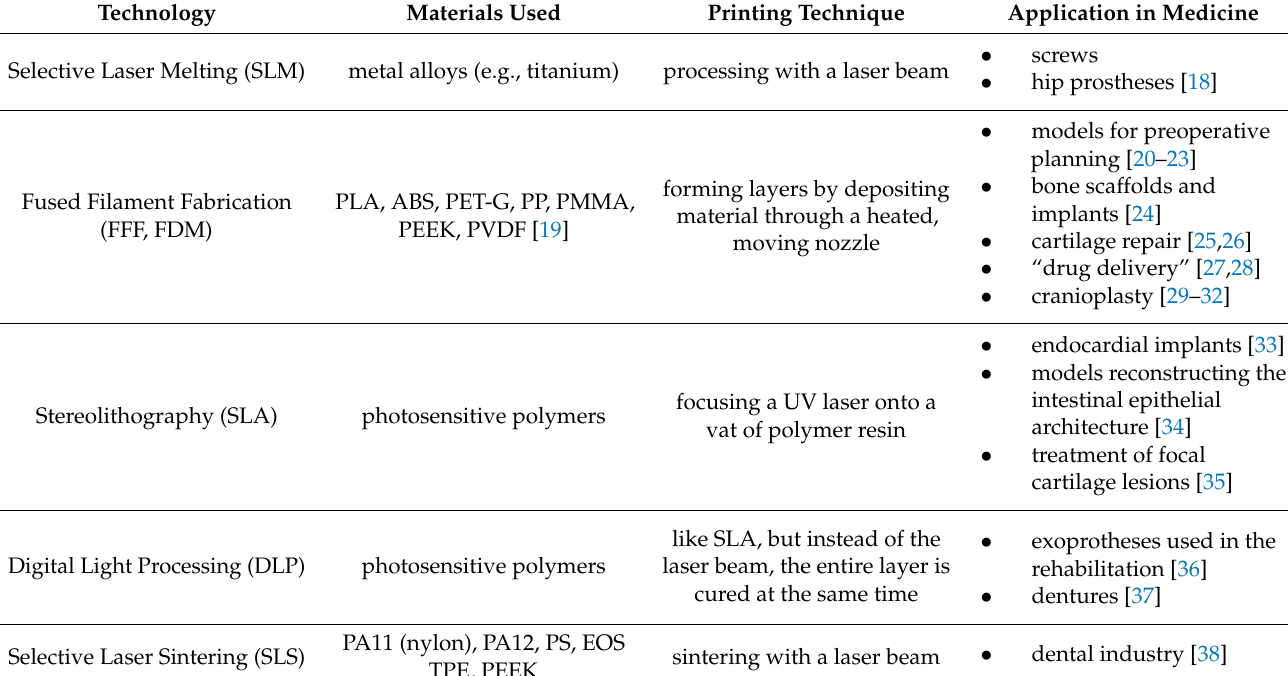
Table 1. Summary of properties of the 3D-printing